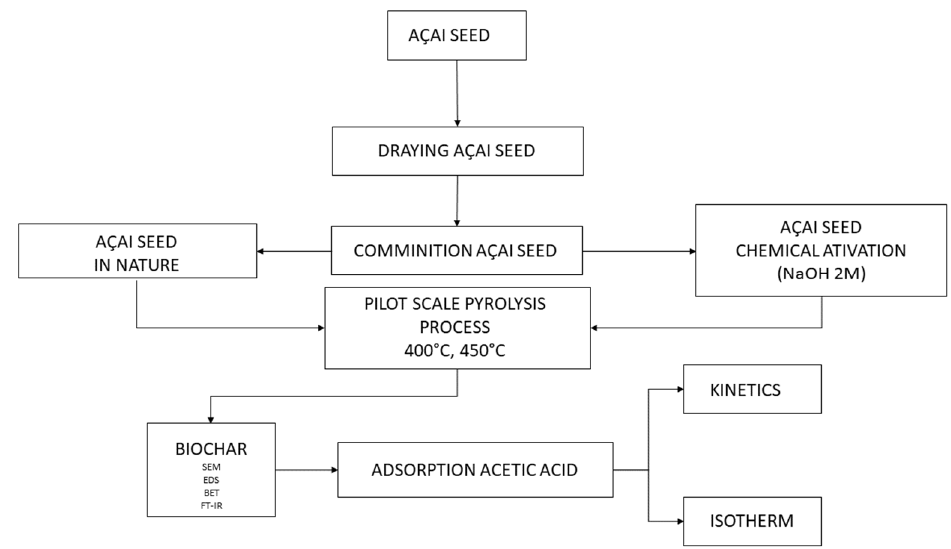
Figure 3. Process diagram of adsorption of acetic acid (Author).